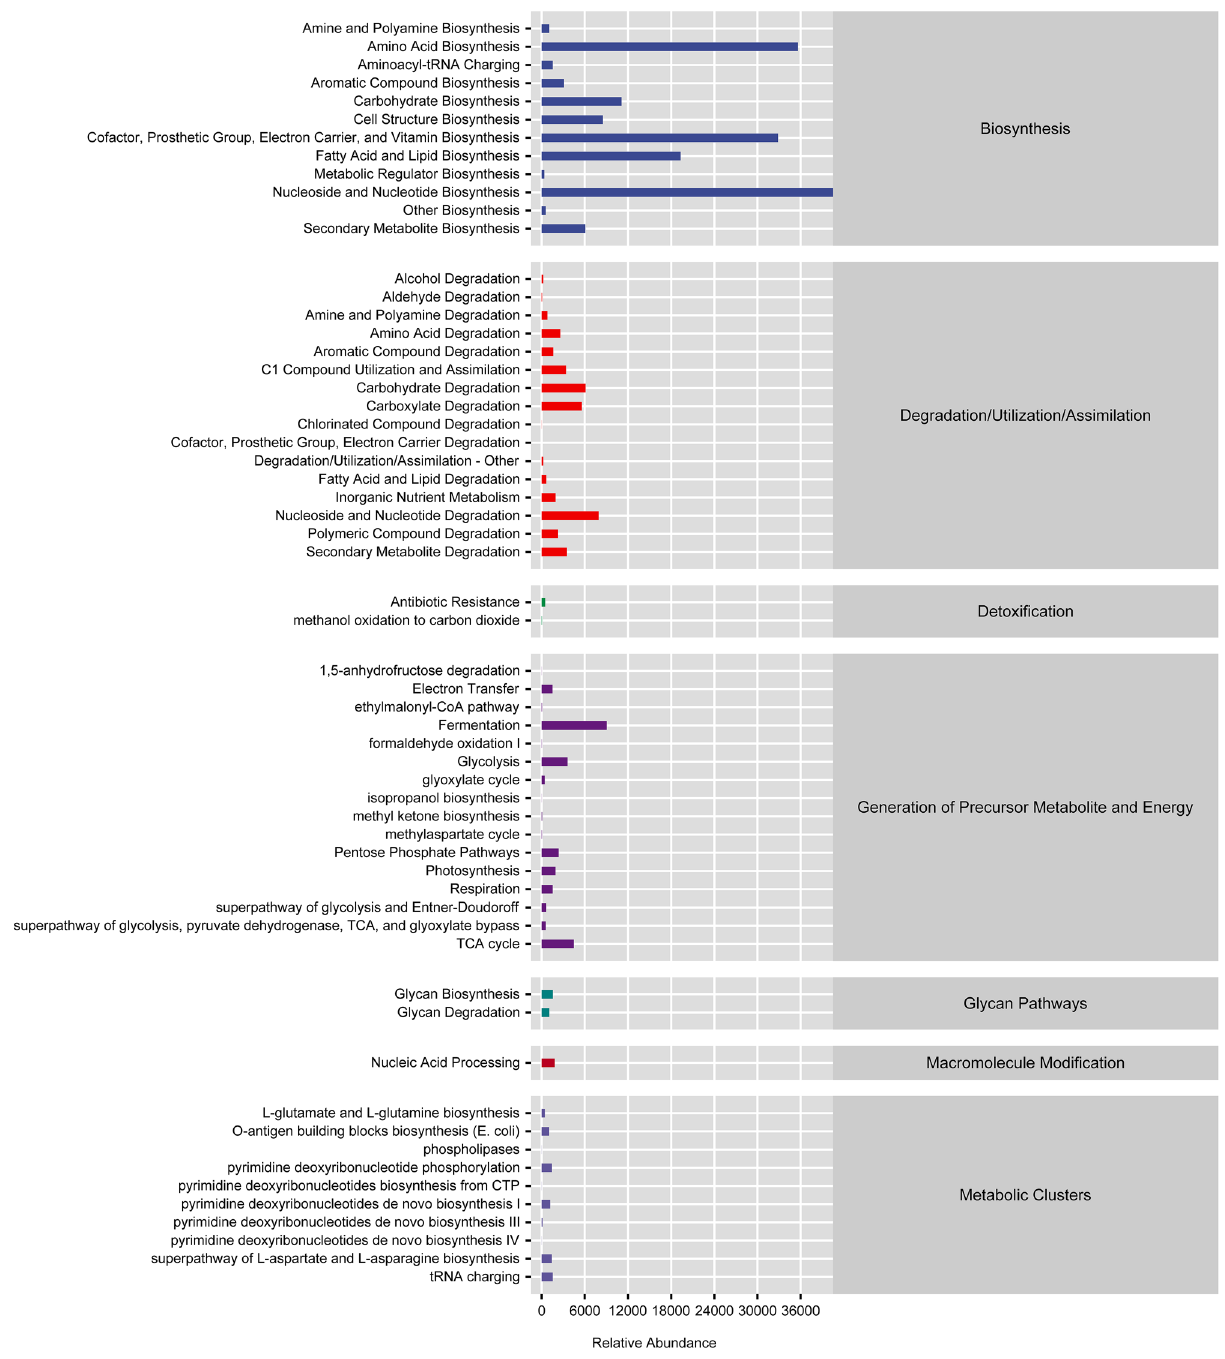
Figure 5. The relative abundance of metabolic